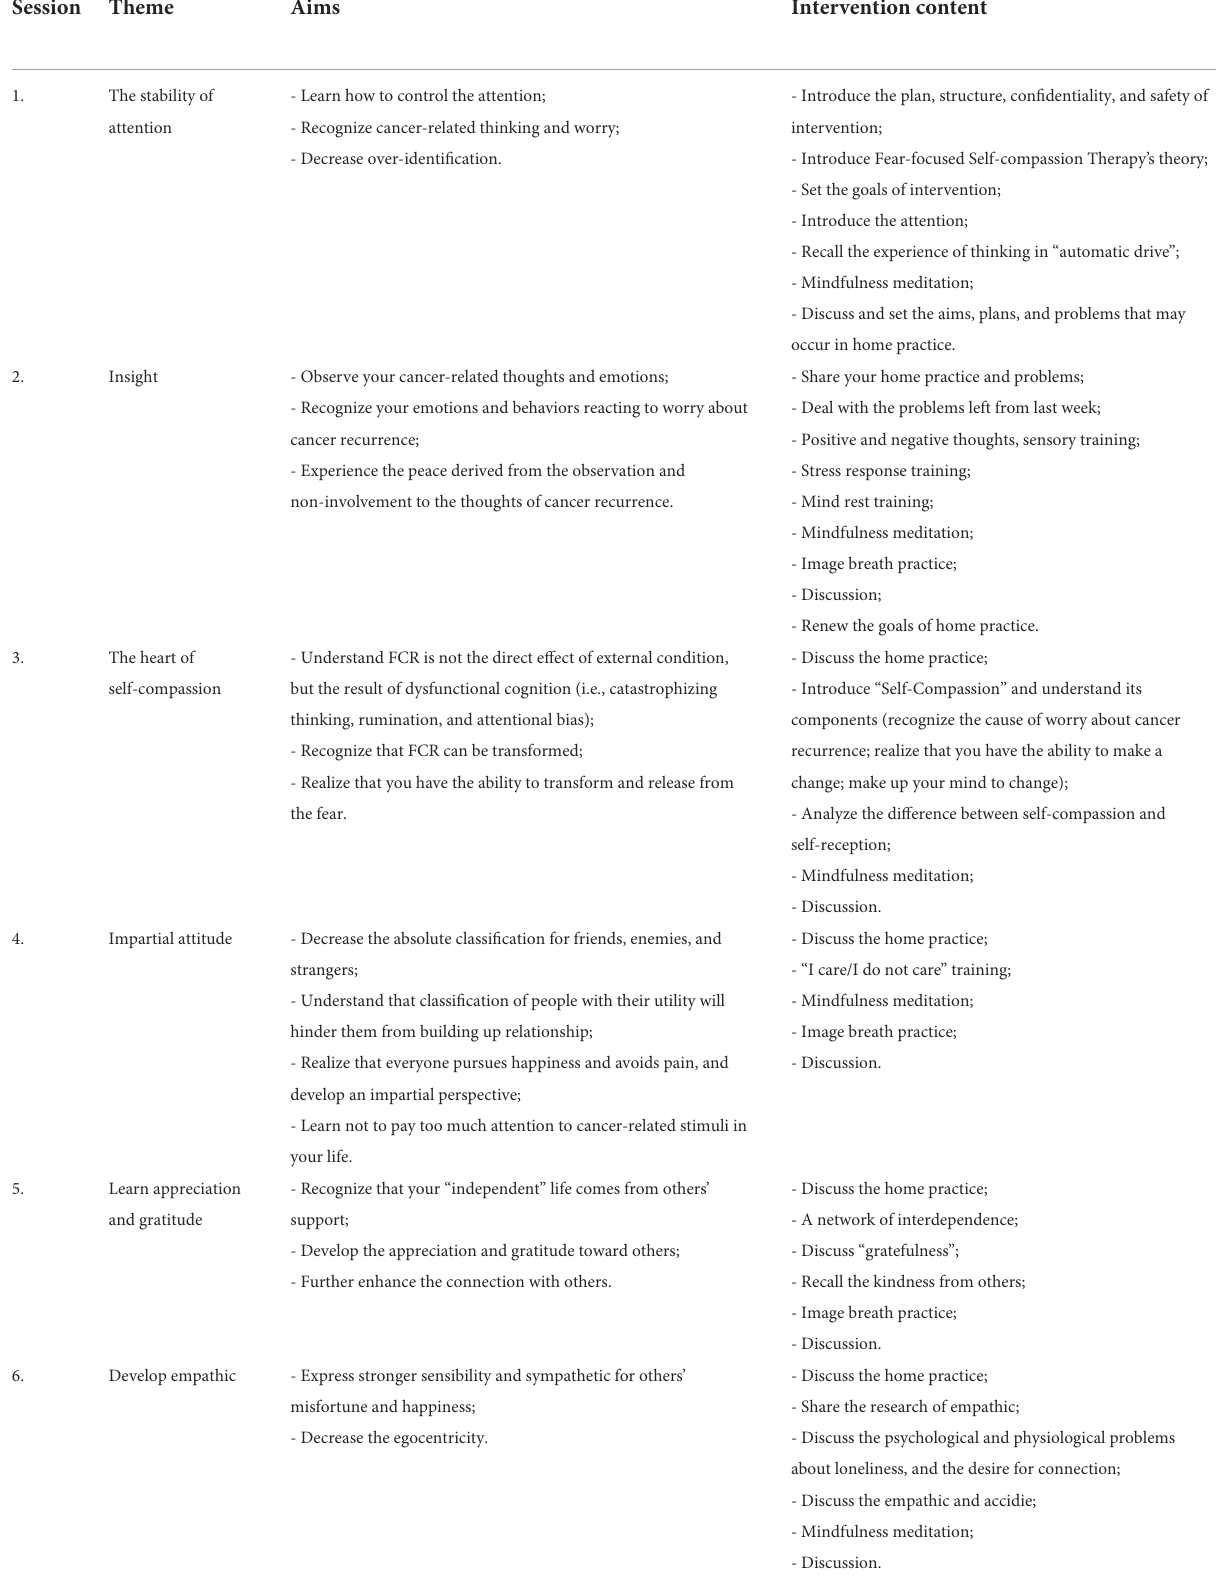
TABLE 1 Content of fear-focused self-compassion therapy sessions. Session